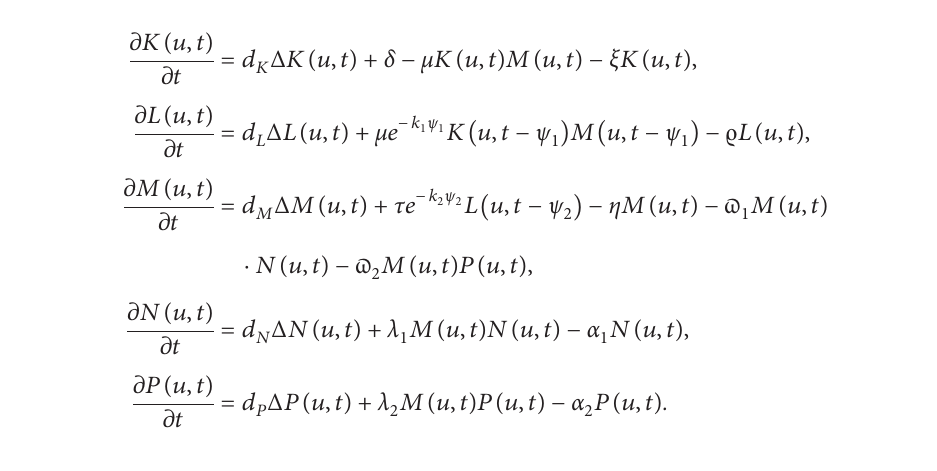
Figure 4: Taking Strategy 1 ( R cells. (b) DENV-infected cells. (c) DENV particles. (d) Heterologous antibodies. (e) Homologous